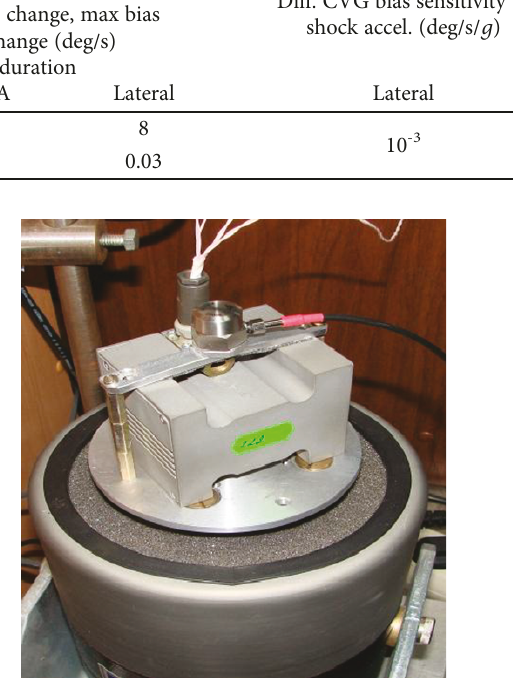
Figure 9: CVG mounted on shaker platform.